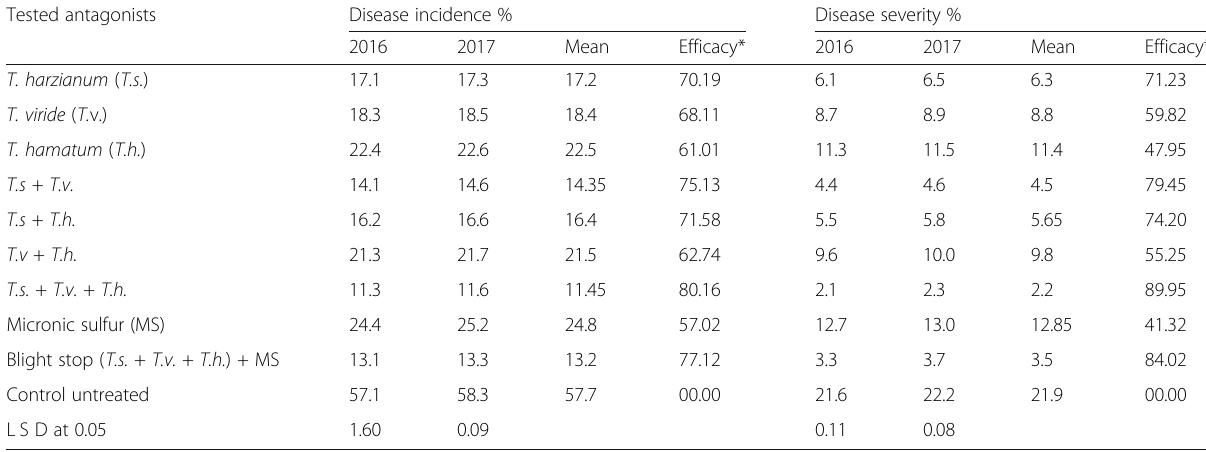
Table 1 Efficacy of different antagonists on powdery mildew of Thompson grapevine disease parameters (incidence and severity) under Egyptian field conditions during 2016 and 2017 seasons Tested antagonists Disease incidence %